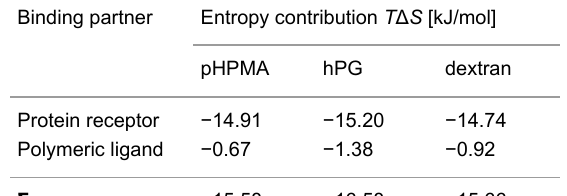
modes are strongly favoured through enthalpic gain, the free energy gain is limited by the entropy loss, most likely caused by the flexibility of the linker and thus a larger number of alter- native conformational states of the protein receptor.